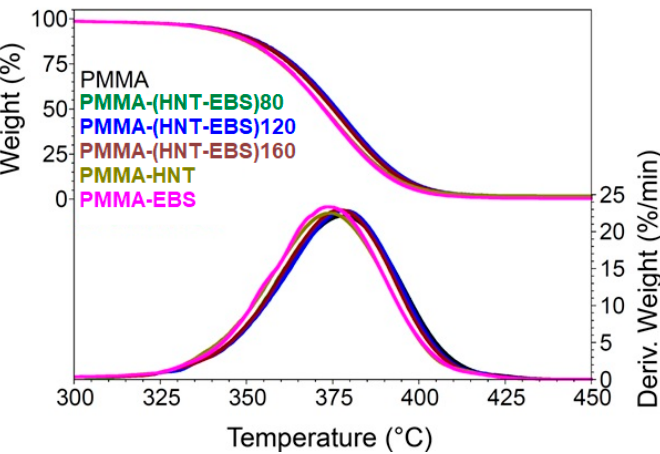
Figure 2. Synergistic effects between EBS and HNT, acting on PMMA decomposition fractions.